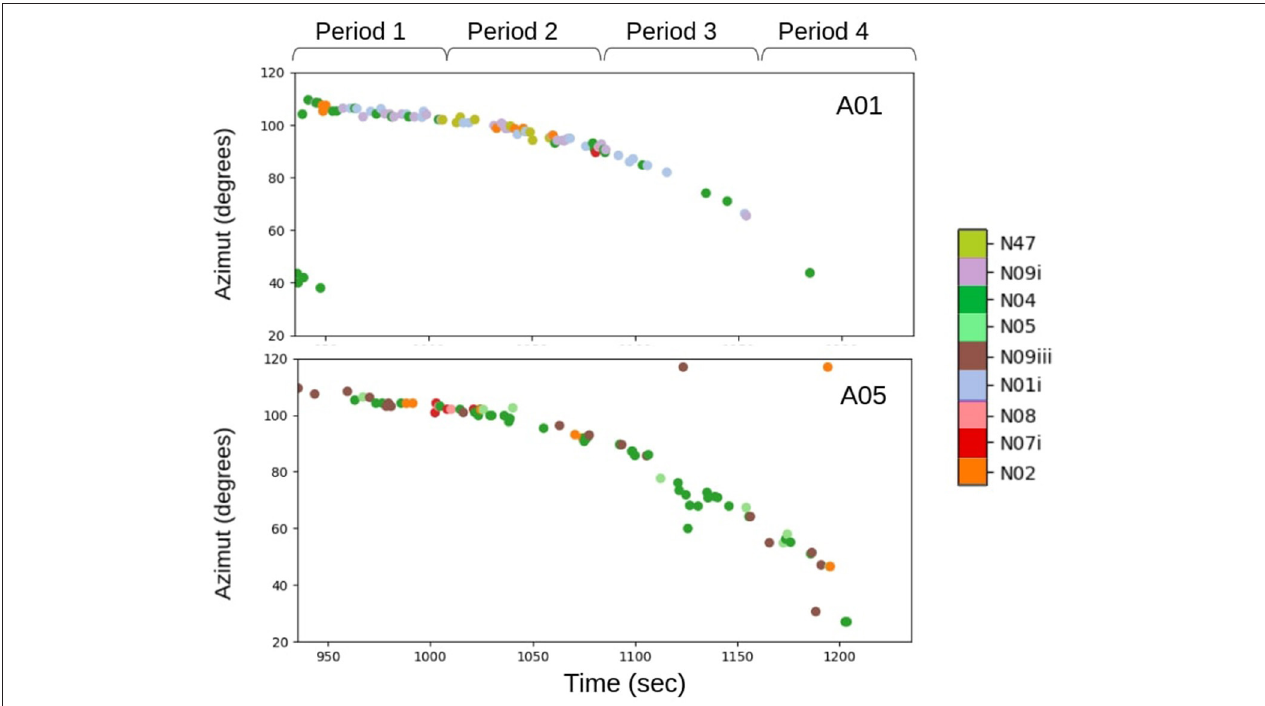
FIGURE 9 | Graph of the passages of the 30th of August. Each point represents a vocalization placed in azimuth. Each color represents a type of call. Top: trajectory of the A01s, Bottom: trajectory of the A05s.